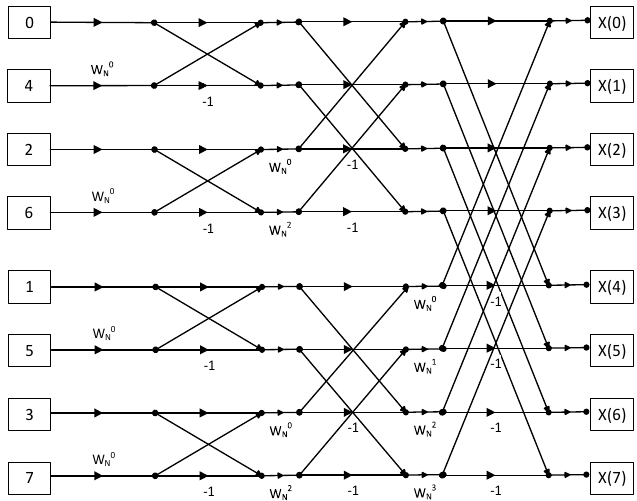
Figure 3. The butterfly algorithm used to compute the decimation in time (DIT) FFT.